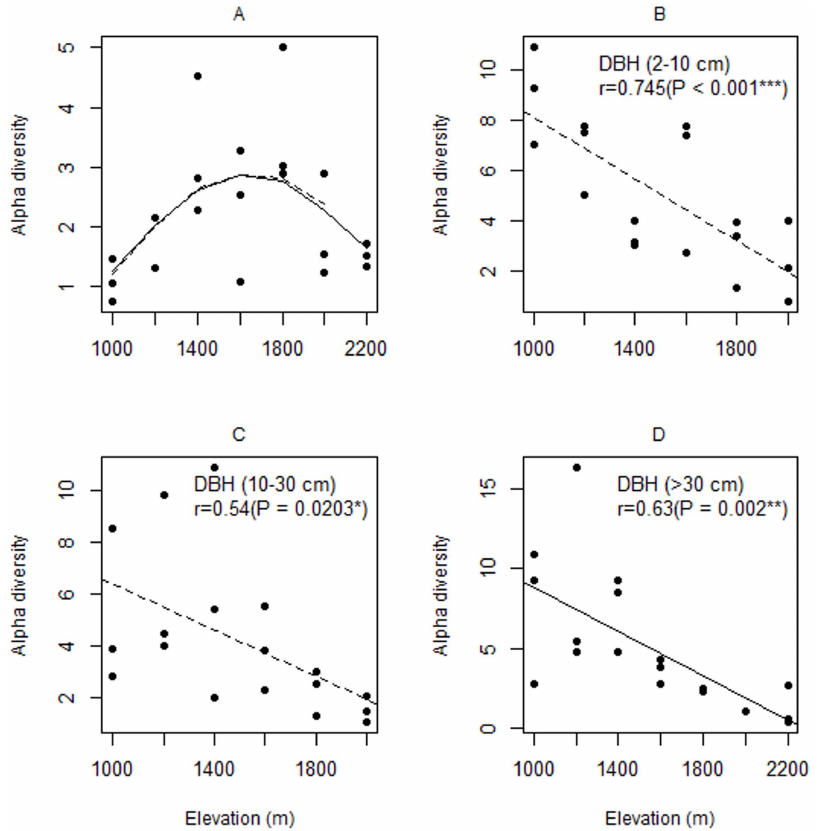
Figure 3. Relationships between elevation and alpha-diversity (Fisher’s alpha) for different components of vegetation on Mt Rinjani, Indonesia. (A) ground-cover plants (y=2.33 + 1.75x-2.39x 2 ), (B) understorey plants (y=14.24-0.006x), (C) subcanopy plants (y=10.90- 0.005x), (D) canopy plants (y=16.43-0.007x). Solid lines indicate relationships including all elevation stations and the dashed lines indicate the relationships when the station at 2200 m (fire-maintained grassland) was omitted. Only relationships that were significant (p , 0.05) in univariate regression models are shown.